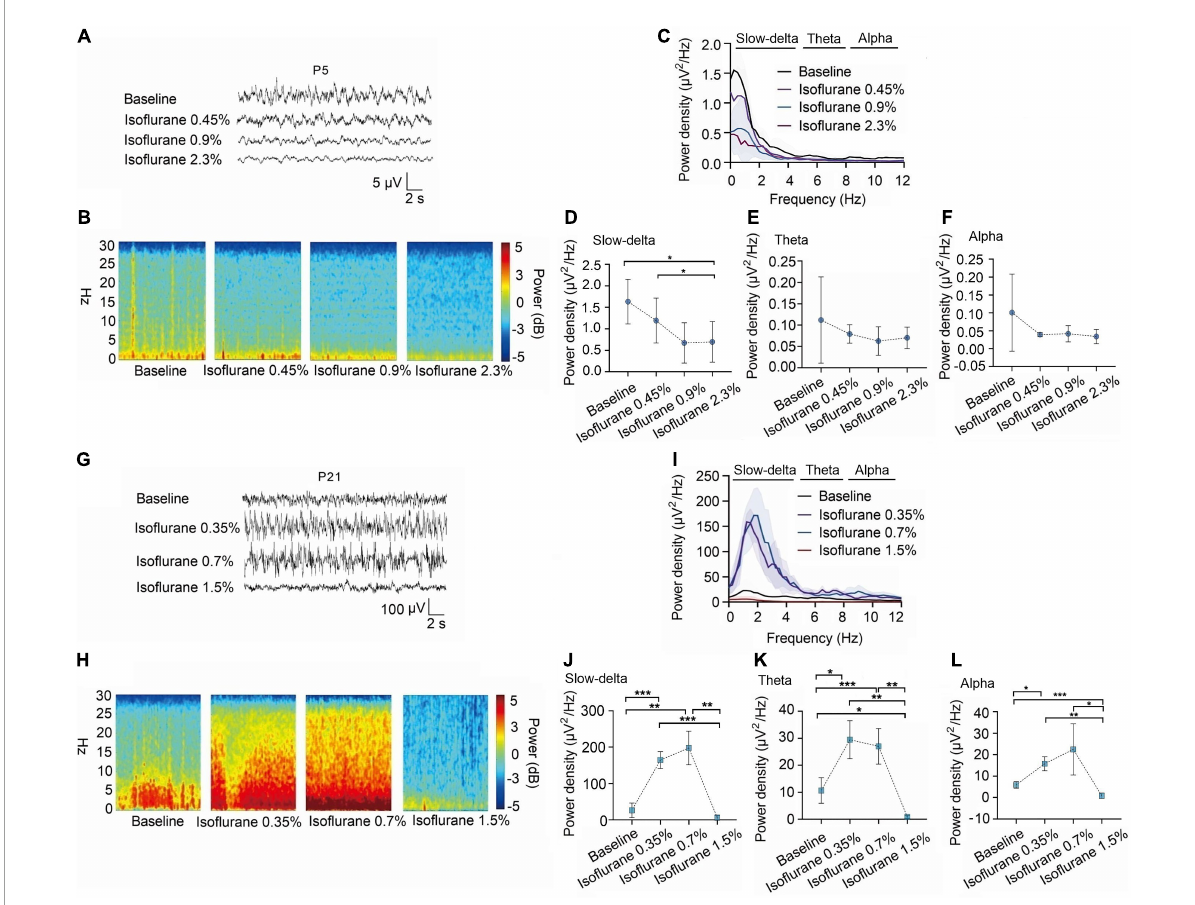
FIGURE3 In P5 rats, isoflurane reduced the power density of slow-delta oscillations, while in P21 rats, it increased the power density of slow-delta, theta and alpha oscillations. (A,B) EEG and it’s power spectrogram of P5 rats under 50%MAC LORR , MAC LORR and MAC immobility of isoflurane. (G,H) EEG and it’s power spectrogram of P21 rats under 50%MAC LORR , MAC LORR and MAC immobility of isoflurane. (C,I) EEG power spectral density of P5, P21 rats at elevated isoflurane concentrations ( n = 5). (D–F) The change of power density of slow-delta, theta and alpha oscillations on P5 rats. (J–L) The change of power density of slow-delta, theta and alpha oscillations on P21 rats. Data are presented as mean ± SD. * P < 0.05, ** P < 0.01, *** P < 0.001 by repeated measures one-way ANOVA (D–F, J–L)